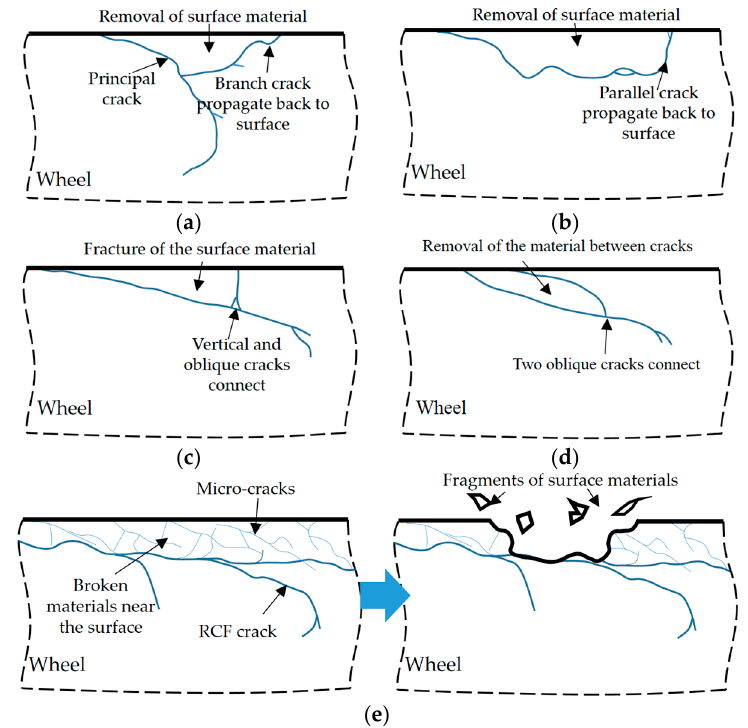
Figure 12. Schematic diagram of the processes of RCF damage: ( a ) and ( b ) cracks propagating back to surface, ( c ) and ( d ) crack connection, ( e ) fragments of surface materials.